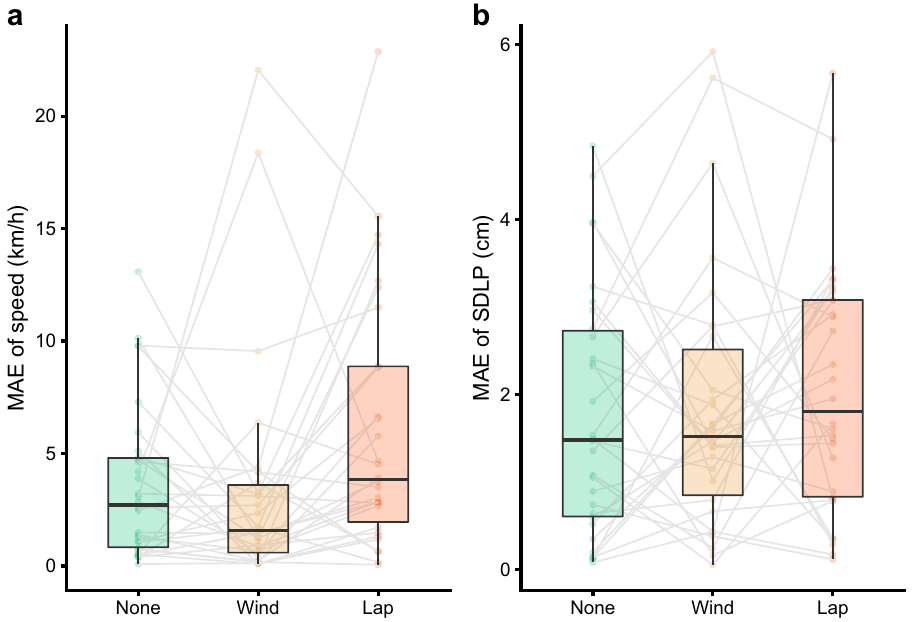
Figure 4. Comparison of the change in driving behaviour (mean absolute error, MAE) from the 10 s preceding—compared to the 5 s following—the arrival of a text message in terms of ( a ) vehicle speed, and ( b ) standard deviation of lane position (SDLP). We observed greater variation in speed after receiving the text message on a laptop cellphone, compared to the window position. There was no difference in SDLP between